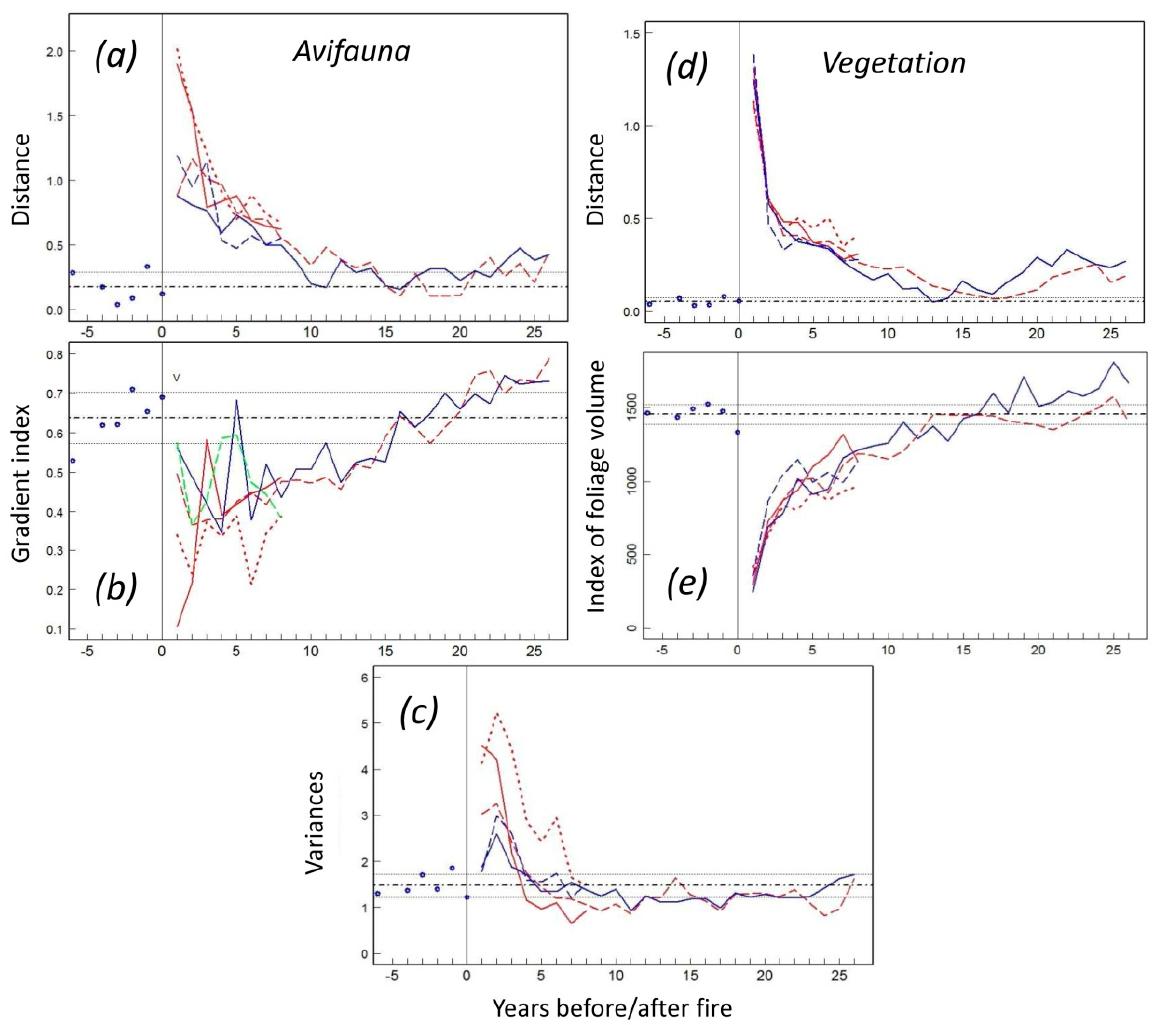
Figure 4. ( a ) Euclidian distance of the burned samples to the mean position of the prefire samples in the first two-dimensional space of the correspondence analysis of the bird matrix. ( b ) Indexation of the burned and unburned samples on the reference grassland-to-forest gradient; the position of the comparative control transect V is indicated. ( c ) Alpha diversity (sum of the conditional within-sample variances on the two first axes of correspondence analysis of the bird matrix). ( d ) Euclidian distance of the burned samples to the mean position of the prefire samples in the first two-dimensional space of the correspondence analysis of the vegetation cover matrix. ( e ) Index of foliage volume. x -axis: years since the last fire. Graphic conventions: see Figure 2.